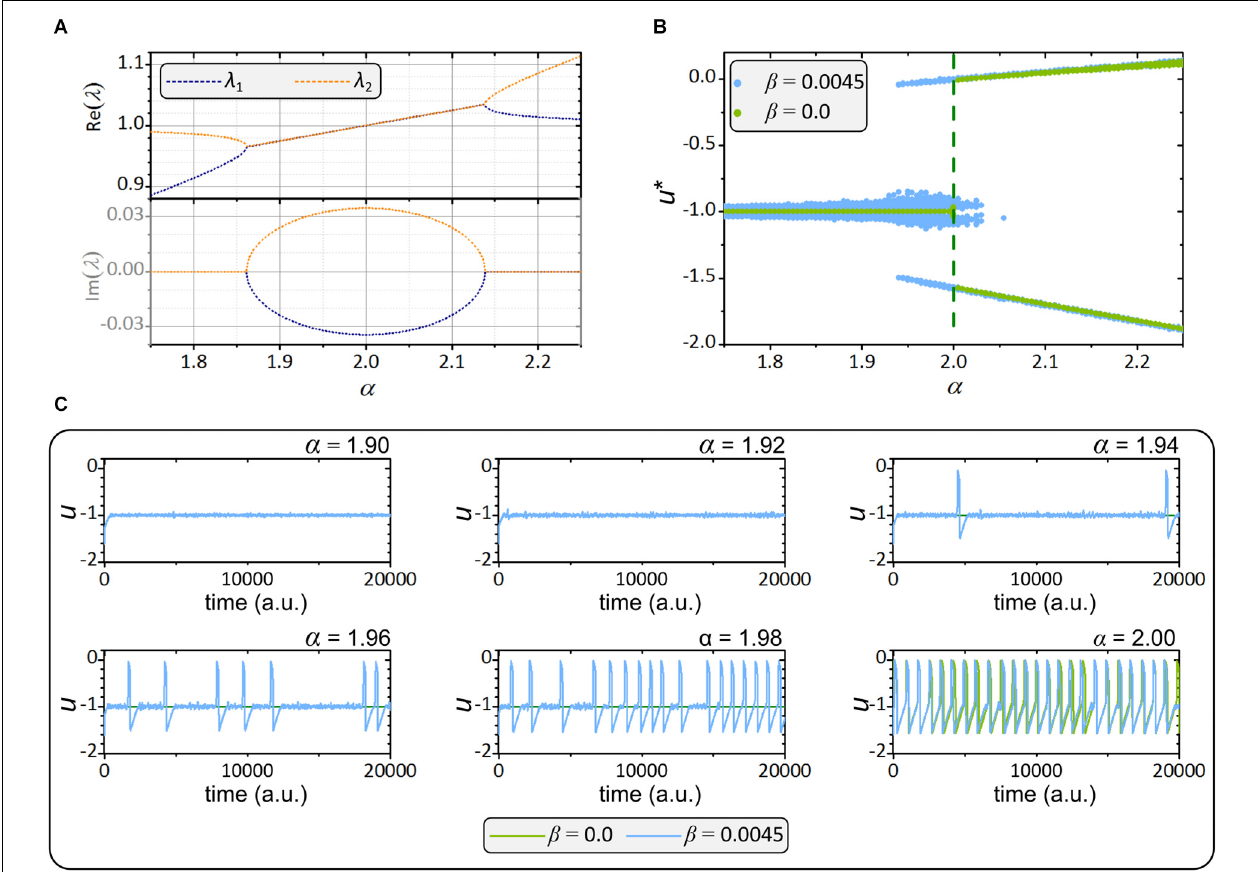
FIGURE 1 | Dynamical features of the Rulkov map. (A) Real and imaginary eigenvalues λ 1 and λ 2 for different values of the control parameter α . (B) Bifurcation diagram of the fast variable with (blue) and without (green) added noise. (C) Traces of the fast variable with (blue) and without (green) noise for different values of excitability levels α .